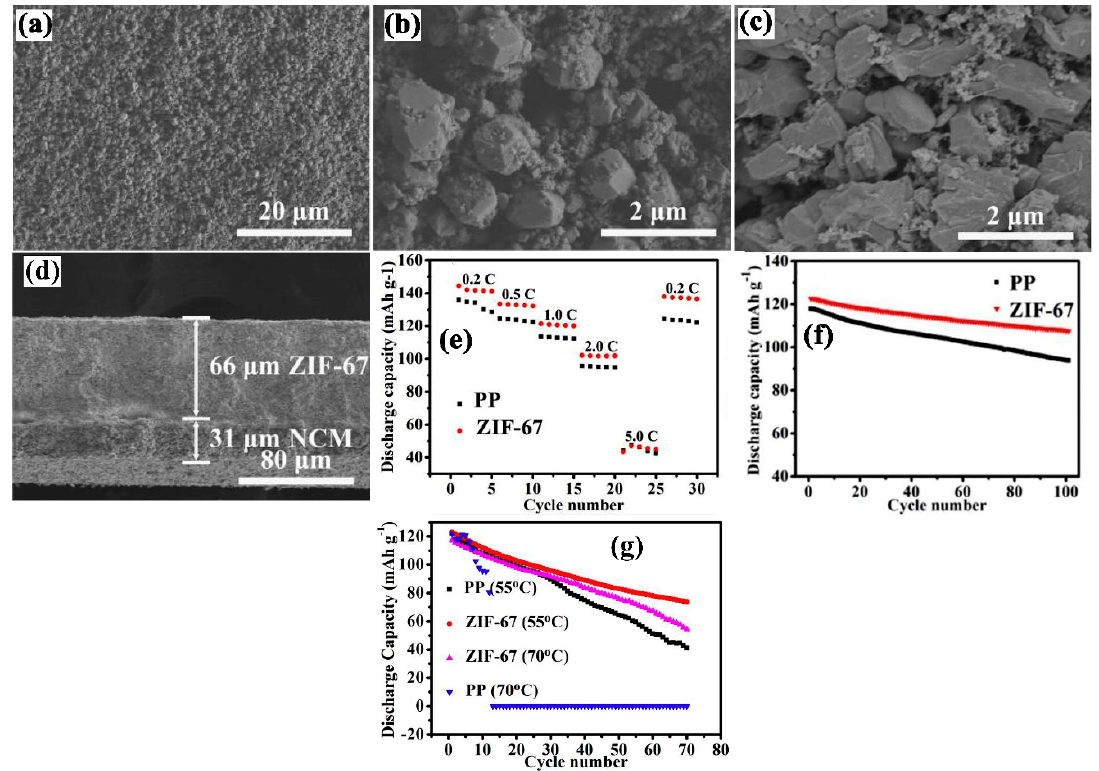
Figure 2. ( a,b ) Top view of ZIF-67 separator with different magnifications. ( c ) top surface image of NCM electrode. ( d ) cross-sectional view of ZIF-67 separator. ( e ) discharge capacities of the PP separator and ZIF-67 separator at different C rates. ( f ) discharge capacities of the PP separator and ZIF-67 separator at the rate of 1.0 C. Inset ( f ) discharge capacities of the PP and ZIF-67 separator under 55 and 70 °C at 1.0 C rate ( g ) Discharge capacity of the PP separator and the ZIF-67 separator at 1.0 C under 55 and 70 °C. [69], with copyright permission from Elsevier.